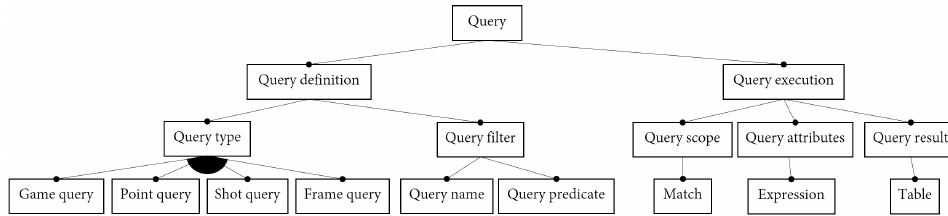
Figure 5. Feature diagram of a query on a padel